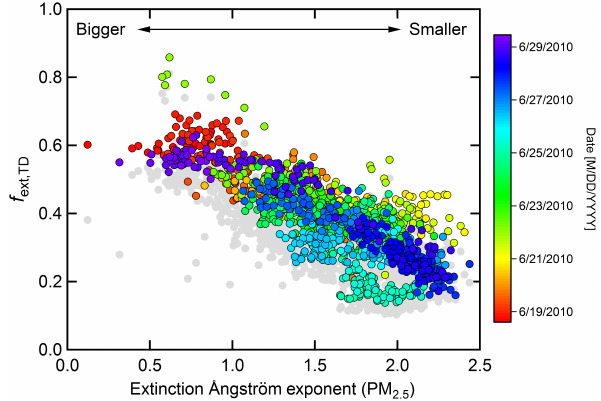
Figure 10. Variation of the extinction fraction remaining at 532nm (colored points) and 405nm (gray points) as a function of the ob- served ambient particle extinction Ångström exponent for PM 2 . 5 . The points are colored by